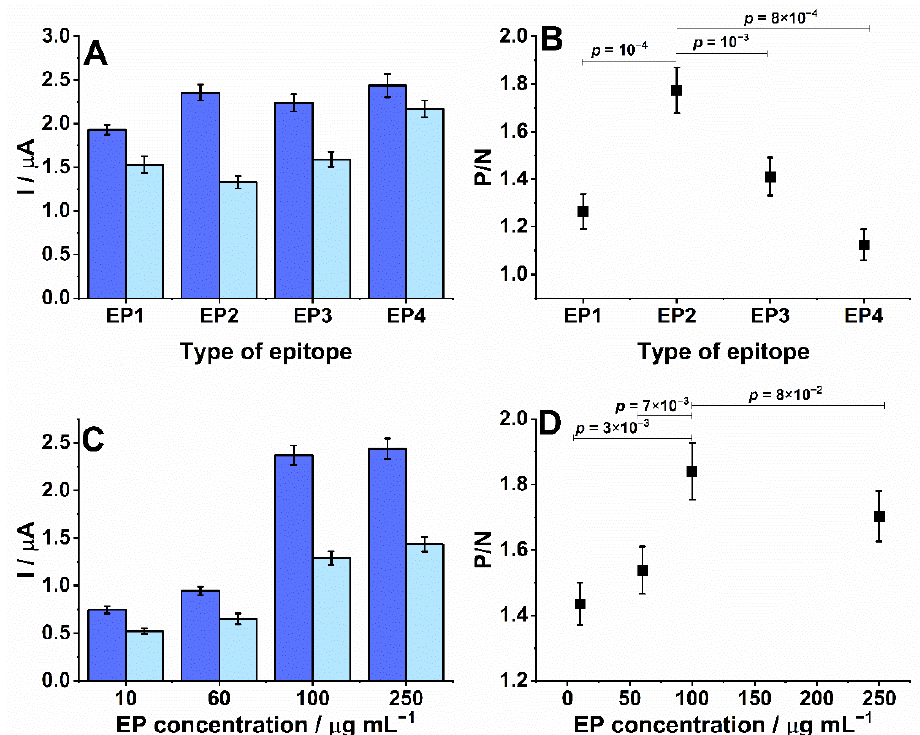
Figure 2. Target choice for conjugation to SPE and measurement optimization. SPEs were sensitized with peptides that represented four EPs identified in the SARS-CoV-2 spike protein. Next, SPEs were incubated with patient sera diluted 1:100 in PBS for 10 min at 37 °C before rinsing. SPEs were similarly incubated with an AP-labeled anti-human secondary (1:30,000), rinsed and presented with 5 mM diPho-HQ in 100 mM Tris-HCl and 20 mM MgCl 2 (pH 9.8) for its enzymatic conversion to HQ. ( A ) Peak currents measured by SWV from positive (blue) or negative (light blue) sera using SPE sensitized with EP1-EP4. ( B ) Ratio between positive and negative signals (P/N) from graph A. ( C ) Peak currents measured from positive (blue) and negative (light blue) sera with SPEs sensitized over a range of EP2 peptide concentrations (10–250 µg mL − 1 ). ( D ) Ratio between positive and nega-tive signals (P/N) for data in graph C. All experiments were performed in duplicate. Solution vol-umes were 2 µL for antibody solutions and 50 µL for washes. Antibody incubations were for 8 min at 37 °C. The parameters of SWVs for amplitude, frequency, step, and applied potential window were 10 mV, 6.3 Hz, 10 mV, − 0.6–0.6 V (vs. Ag), respectively.